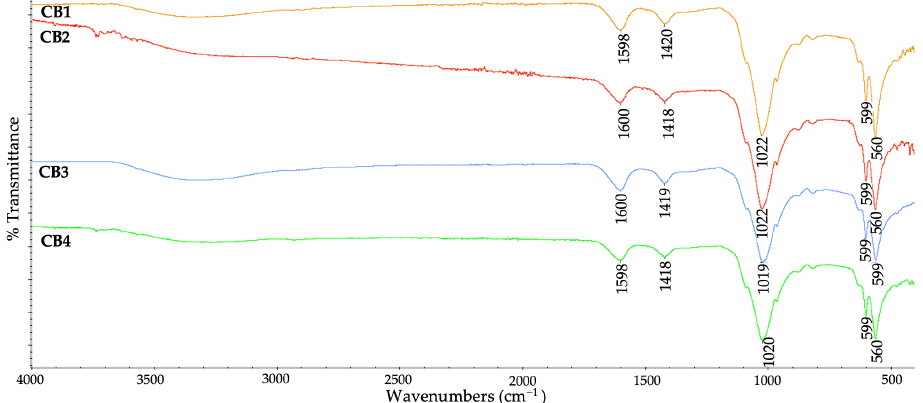
Figure 5. ATR – FTIR spectra of the CBs